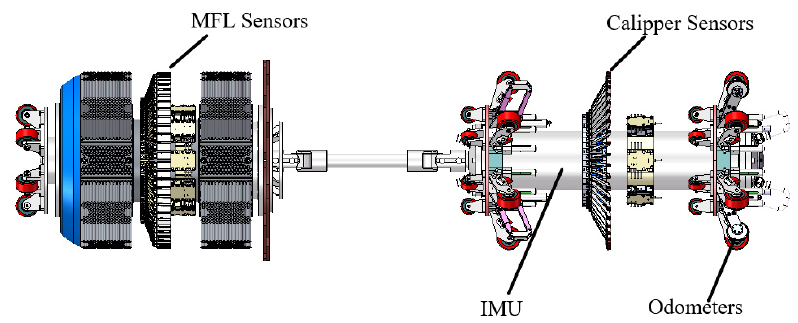
Figure 1. Depiction of the pipeline bending strain in-line inspection system.